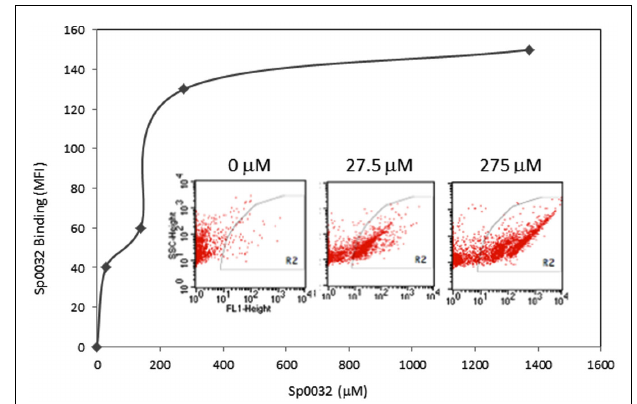
FIGURE 13 | Native Sp185/333 proteins bind Vibrio diazotrophicus ( Vd ), a gram negative marine bacterial species. Whole coelomic fluid (wCF) lysate from a sea urchin was incubated with Vd . Bacteria were pelleted, washed, and analyzed byWestern blot using equal amounts of all three anti-Sp185/333 sera (see legend for Figure 10 ). wCF and Vd alone are shown for comparison. Lane 1, wCF; lane 2, wCF proteins bound to Vd ; lane 3, Vd . Protein standard is to the left. Unpublished figure provided by Catherine Schrankel. 2011). To date,it appears Sp185/333 + cells are present throughout